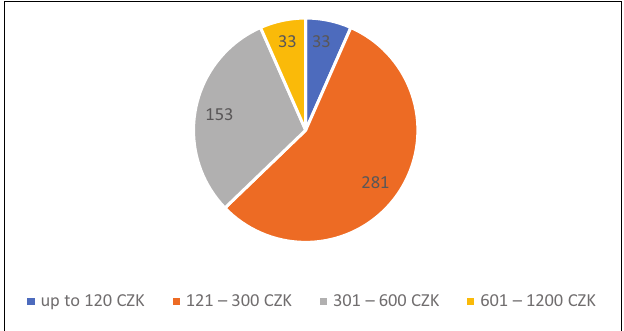
FIGURE 4 | Average amount per person spent during one visit to a restaurant. Source : Own